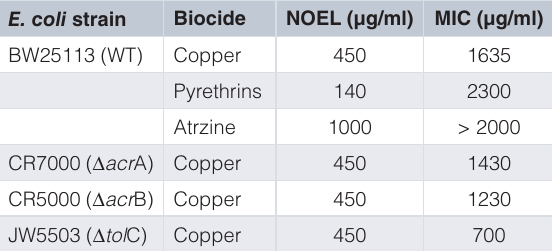
Table 2. Relevant biocide NOEL and MIC